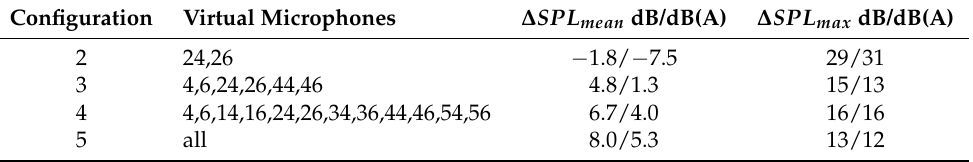
Table 1. Mean and maximum SPL reductions of the configurations averaged over all 60 microphones.